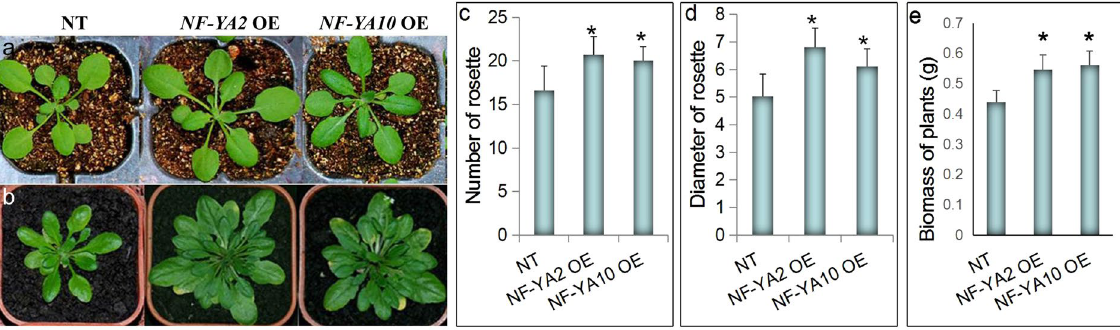
Figure 1. Rosette phenotype of NF-YA2 and NF-YA10 overexpression lines. ( a ) 20-days-seedling; ( b ) plants at bolting stage; ( c ) number and diameter of rosettes for NF-YA2 and NF-YA10 overexpression lines. Thirty plants were measured for each